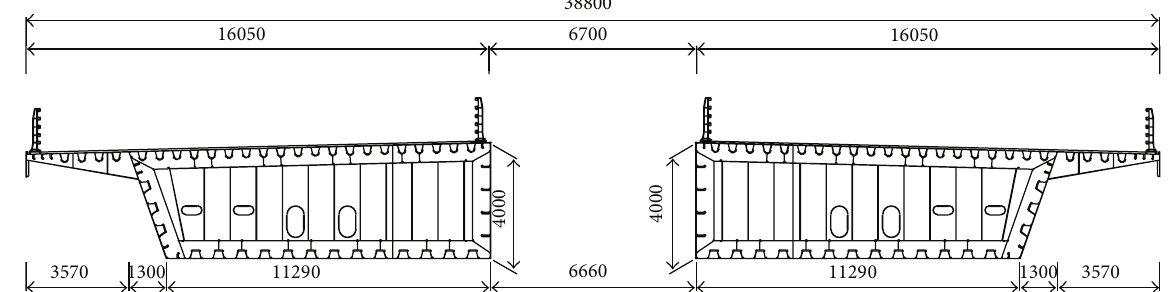
Figure 1: Standard cross section of the girder.